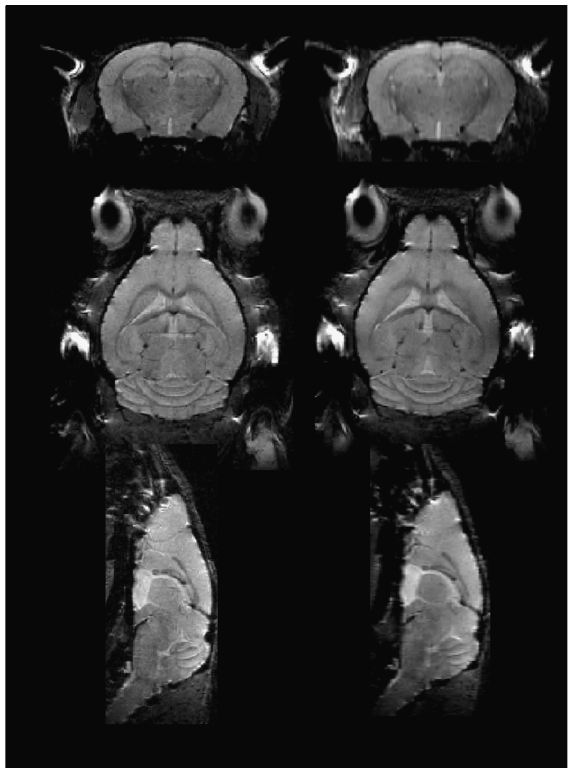
Figure 3. Left column: 100 µm isotropic-resolution scan; Right column: 100 × 100 × 200 µm 3 resolution scan.